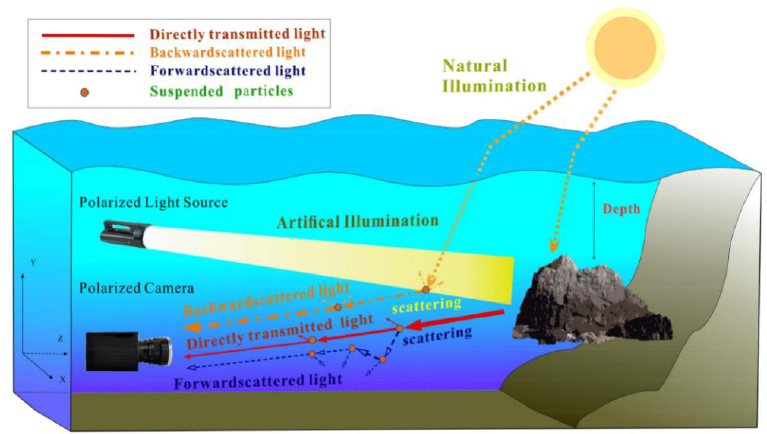
Figure 11. Model of underwater image formation [8].